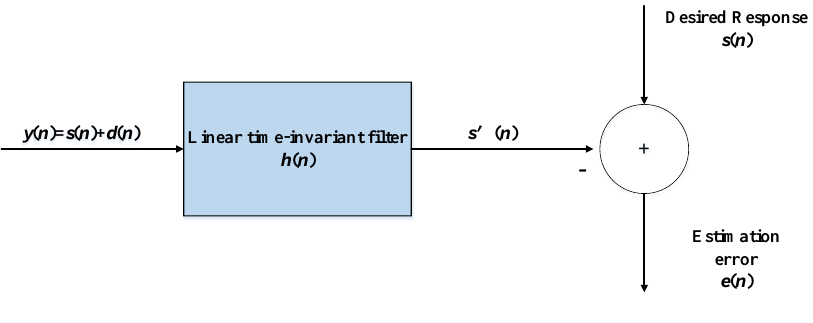
Figure 3. Flow chart of Wiener filtering.